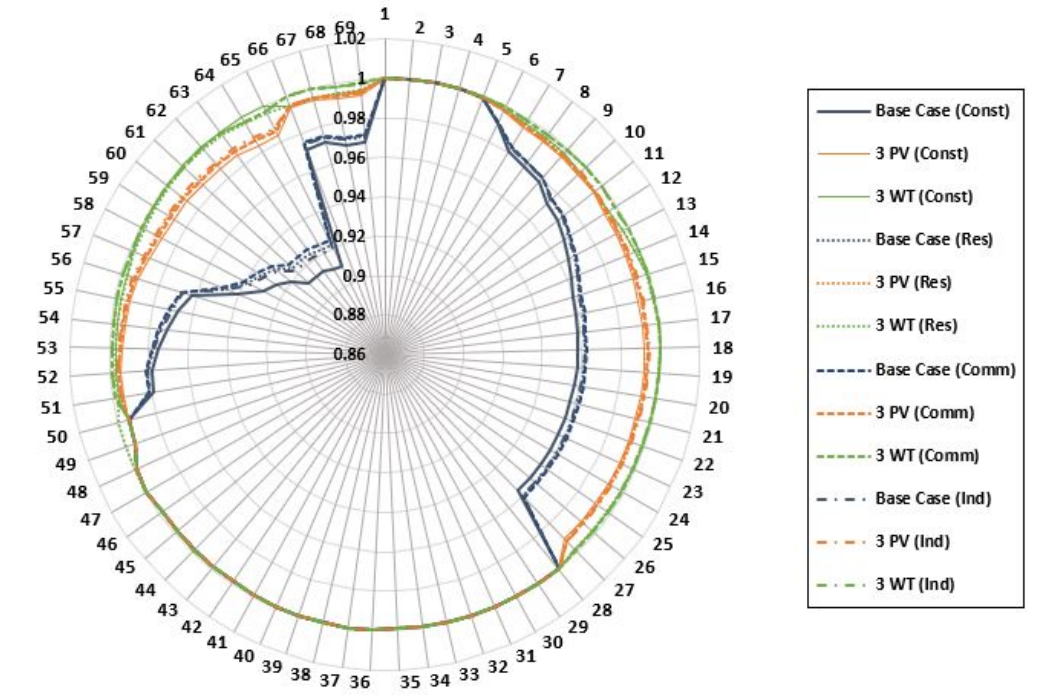
Figure 8. Voltage profiles for an IEEE 69-bus system for different loads at different cases in scenario 1.